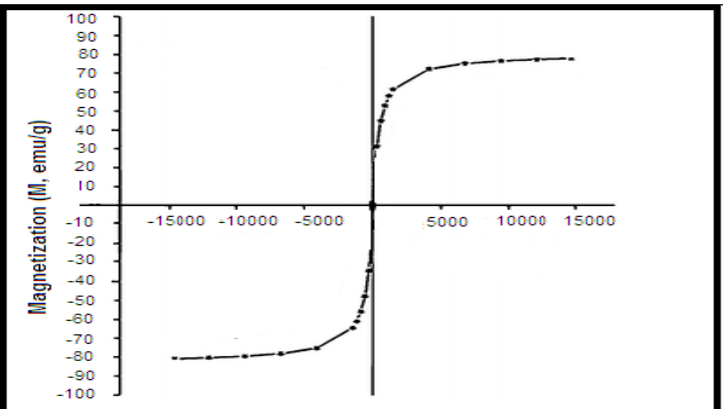
properties.Fig.6. VSM curve of Magnetic Nanoadsorbent.